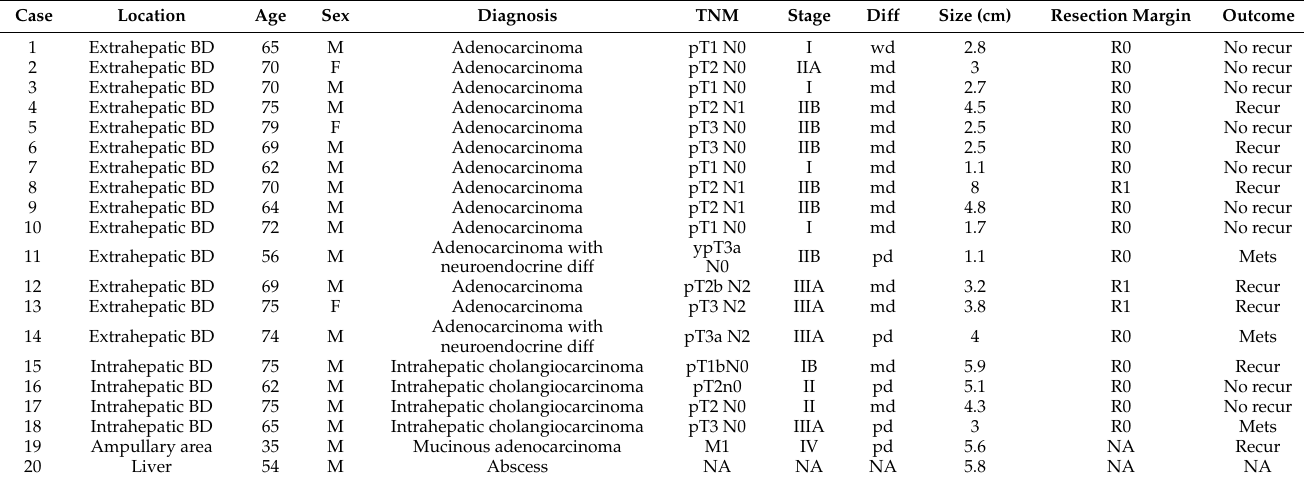
Table 1. Clinicopathologic characteristics of the patients included in this study (N = 20).